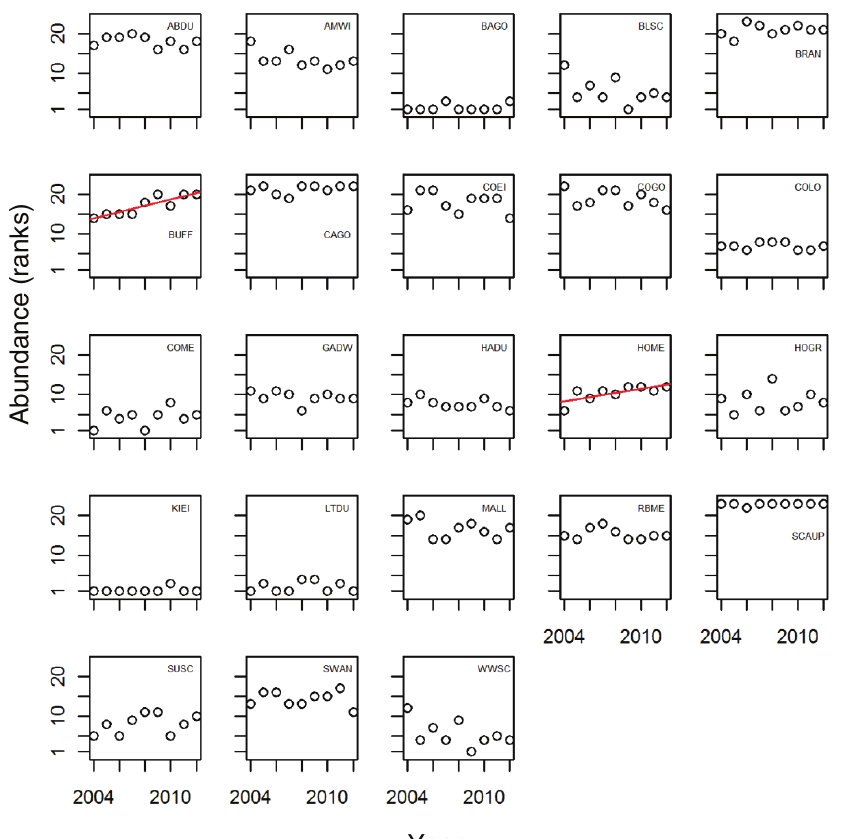
Figure 3. Species ranked abundances.